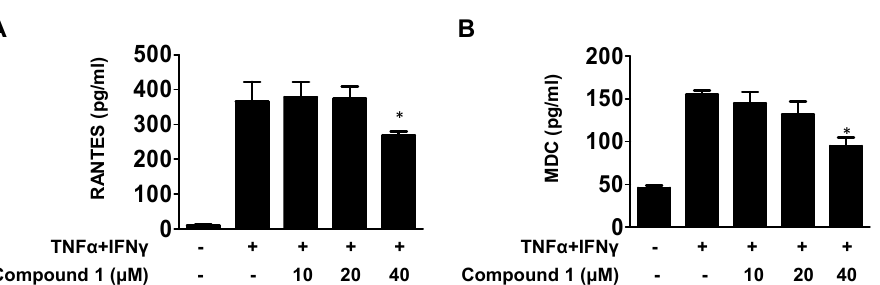
Figure 3. Effects of compound 1 on MDC and RANTES secretion in TNF- α /IFN- γ -stimulated HaCaT cells. ( A , B ) The MDC and RANTES levels were measured using the cell cuture supernatant. Data are represented as the mean ± SD (n = 3). * p < 0.05 vs. TNF- α /IFN- γ -treated group. FLG/IVL in HaCaT Cells lesions, the overexpression of ICAM-1 can be observed [19]. The effects of compound 1 on TNF- α - and IFN- γ -induced ICAM-1 expression were examined. As shown in Figure 4A,B, compound 1 downregulated ICAM-1 expression. Filaggrin (FLG) and involucrin (IVL) are essential for maintaining epidermal barrier function [20]. As shown in Figure 4A,C,D, compound 1 did not affect FLG expression in TNF- α - and IFN- γ -induced HaCaT cells. In contrast, compound 1 upregulated IVL expression.